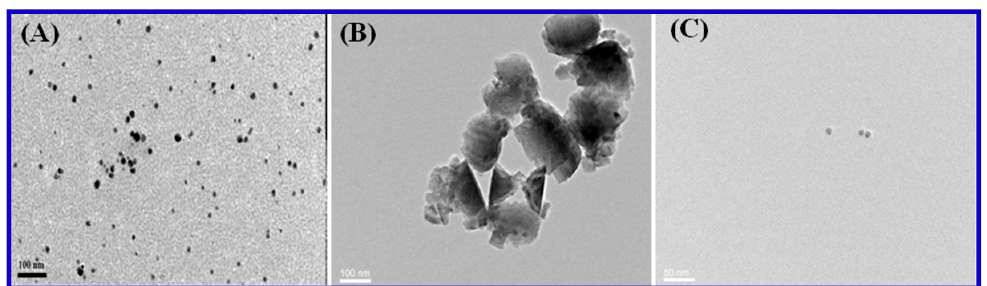
Figure 9. TEM images of ( A ) carrageenan-AgNPs alone, ( B ) carrageenan-AgNPs in the presence of Cu 2 + ions (500 µ M), and ( C ) carrageenan AgNPs in the presence of S 2 − ions (500 µ M).